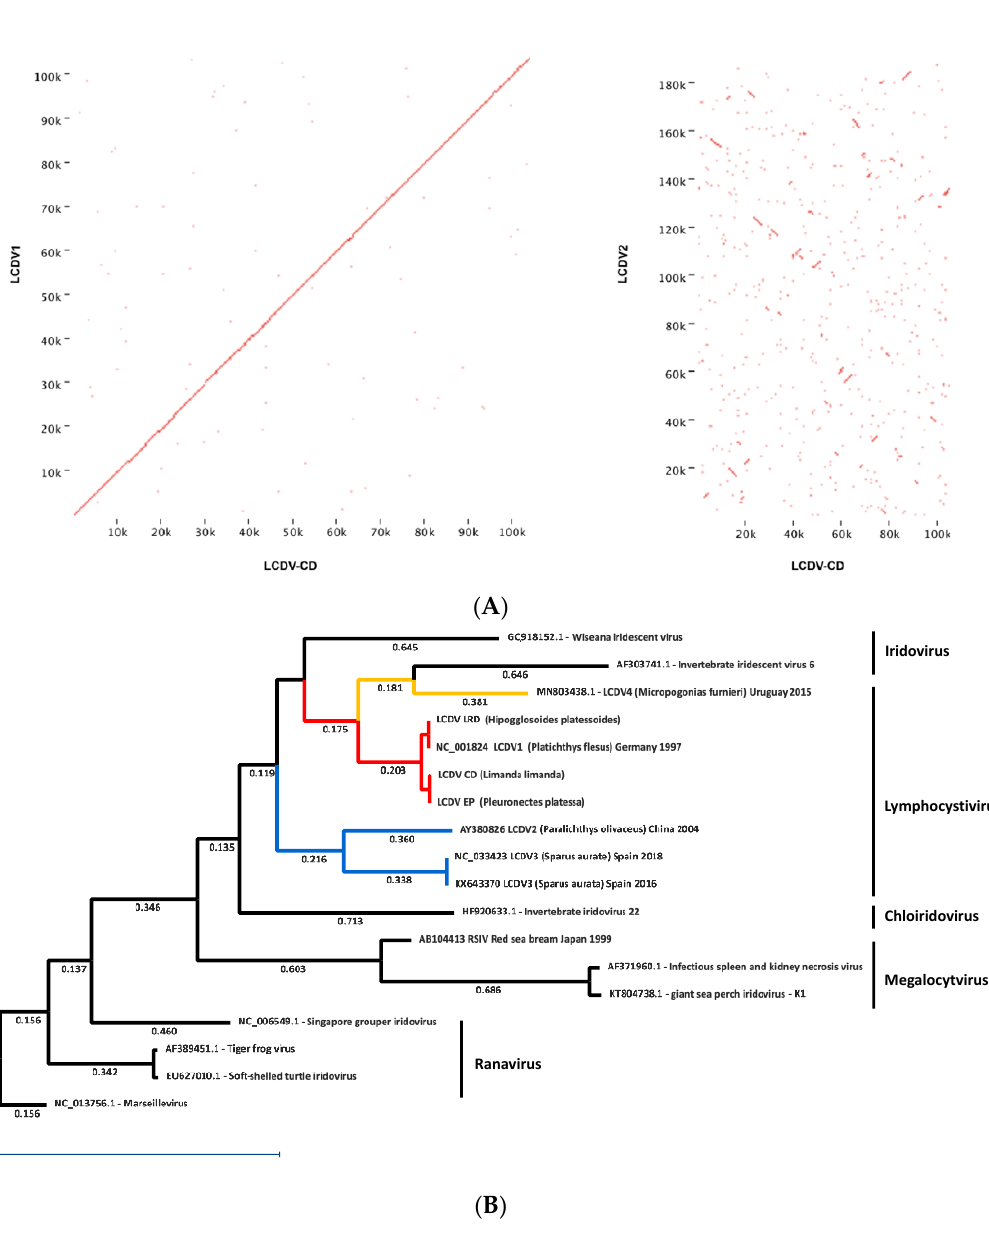
Figure 3. ( A ) Genomic dot plot of LCDV genomes. The left figure shows the comparison of the genomic sequences of LCDV-CD with LCDV1, the right figure shows the comparison of LCDV-CD with LCDV2. ( B ) RAxML maximum likelihood tree (1000 bootstraps) of full genome Iridoviridae sequences. Numbers depict posterior probability values. The bootstrap values are given in Figure S2. Choice of genomes for Betairidoviridae genera Iridovirus and Chlroiridovirus and Alphairidoviridae genera Ranavirus and non- Iridoviridae outgroup nucleocytoplasmic large DNA viruses Marseillevirus, according to [23]. LCDV1-4 are highlighted in red and orange; LCDV2-3 in blue. A MAFFT alignment and RAxML tree of all LCDV and selected representative Iri- dovirus full genome sequences was inferred. It clearly shows a distinct clustering of the LCDV1 sequences from the LCD2–3 sequences but groups in a subclade with LCDV4. A pairwise comparison of shared coding sequences (CDS) revealed that LCDV1 shares only three and four genes with LCDV2 and LCDV3, respectively, but 13 with LCDV4. The genome pair LCDV2–3 shares 24, while LCD3-4 shares 22 CDSs (Figure